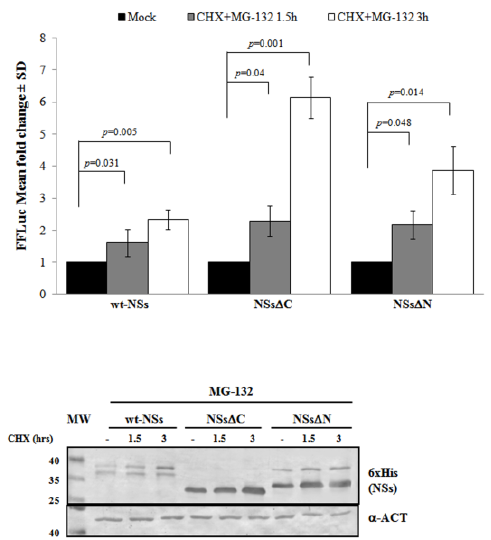
Figure 3. E ff ects of the proteasome inhibitor MG-132 on NSs deleted mutants were evaluated. ( Upper panel ) wt-NSs, NSs ∆ N, and NSs ∆ C expressing cells were treated with 25 µ M of the inhibitors along with 100 µ g / mL of CHX and collected at 1.5 and 3 h. Cell lysates were subjected to a dual-luciferase assay in order to estimate the stability of NSs protein variants. A significant increase of protein stability over time was noticed for wt-NSs, NSs ∆ C, and NSs ∆ N. ( Lower panel ) The immunoblotting with anti-6 × His antibody or anti-ACT performed on MG-132 and CHX treated cells confirmed the stabilizing properties of the MG-132 on the NSs proteins tested. The error bars represent the standard deviation from the mean values obtained in independent experiments.